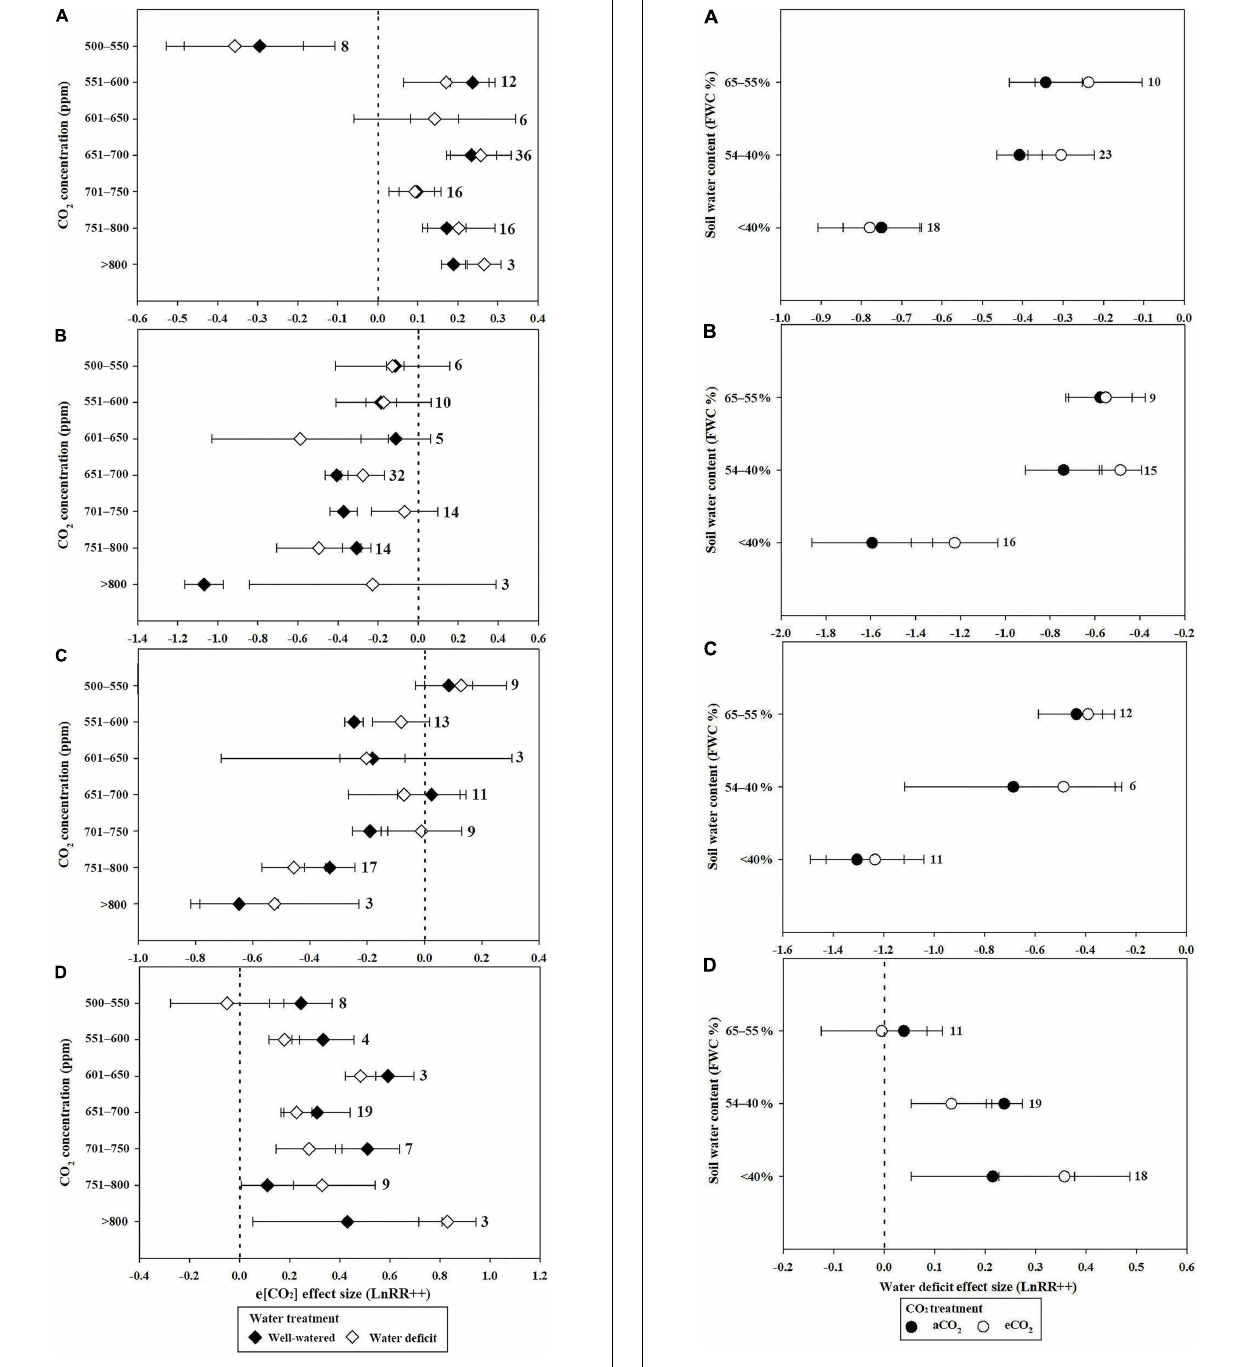
chambers, respectively, under a[CO 2 ] ( Figure 1B ). However, water deficit increased the T r by 9.6% in FACE under e[CO 2 ] treatment ( Figure 1A ). Moreover, e[CO 2 ] reduced T r regardless